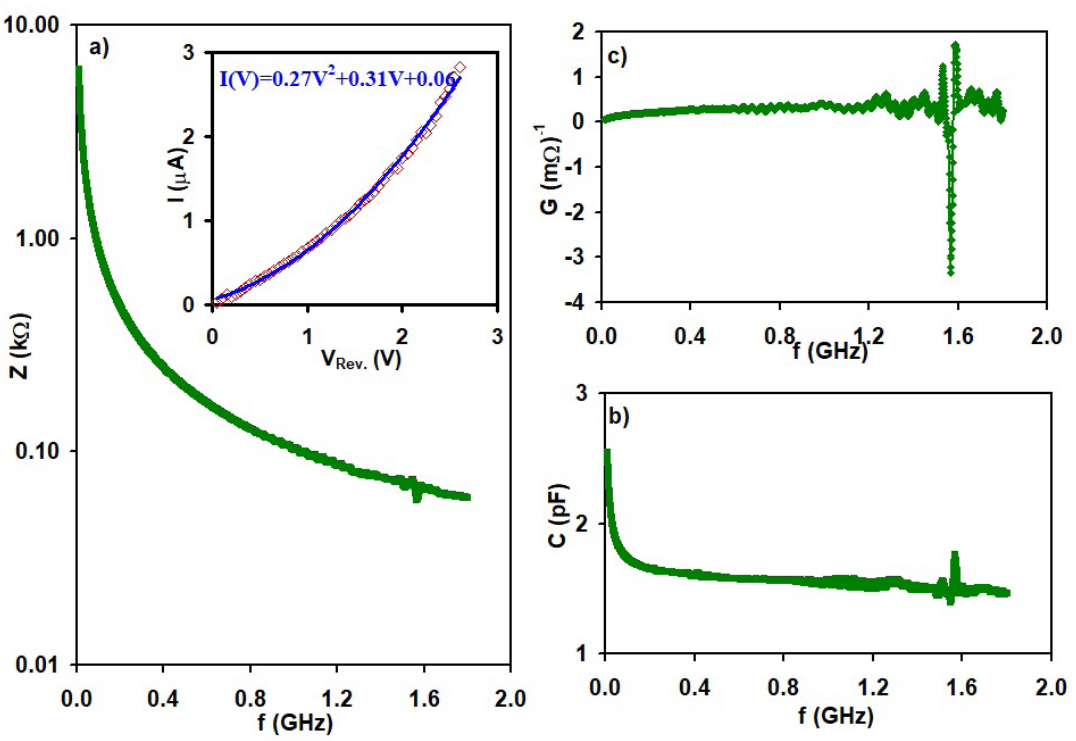
/C diodes. Inset of (a) showing the 2 Rev.